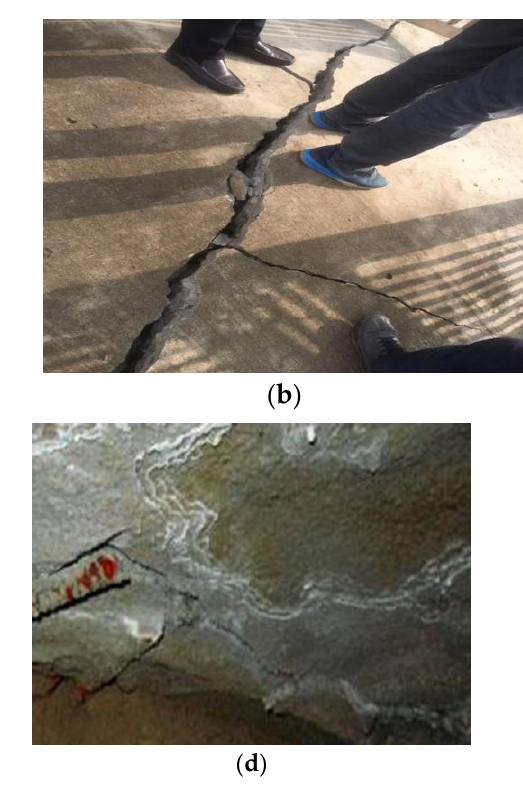
Figure 2. Tunnel section and support parameters.